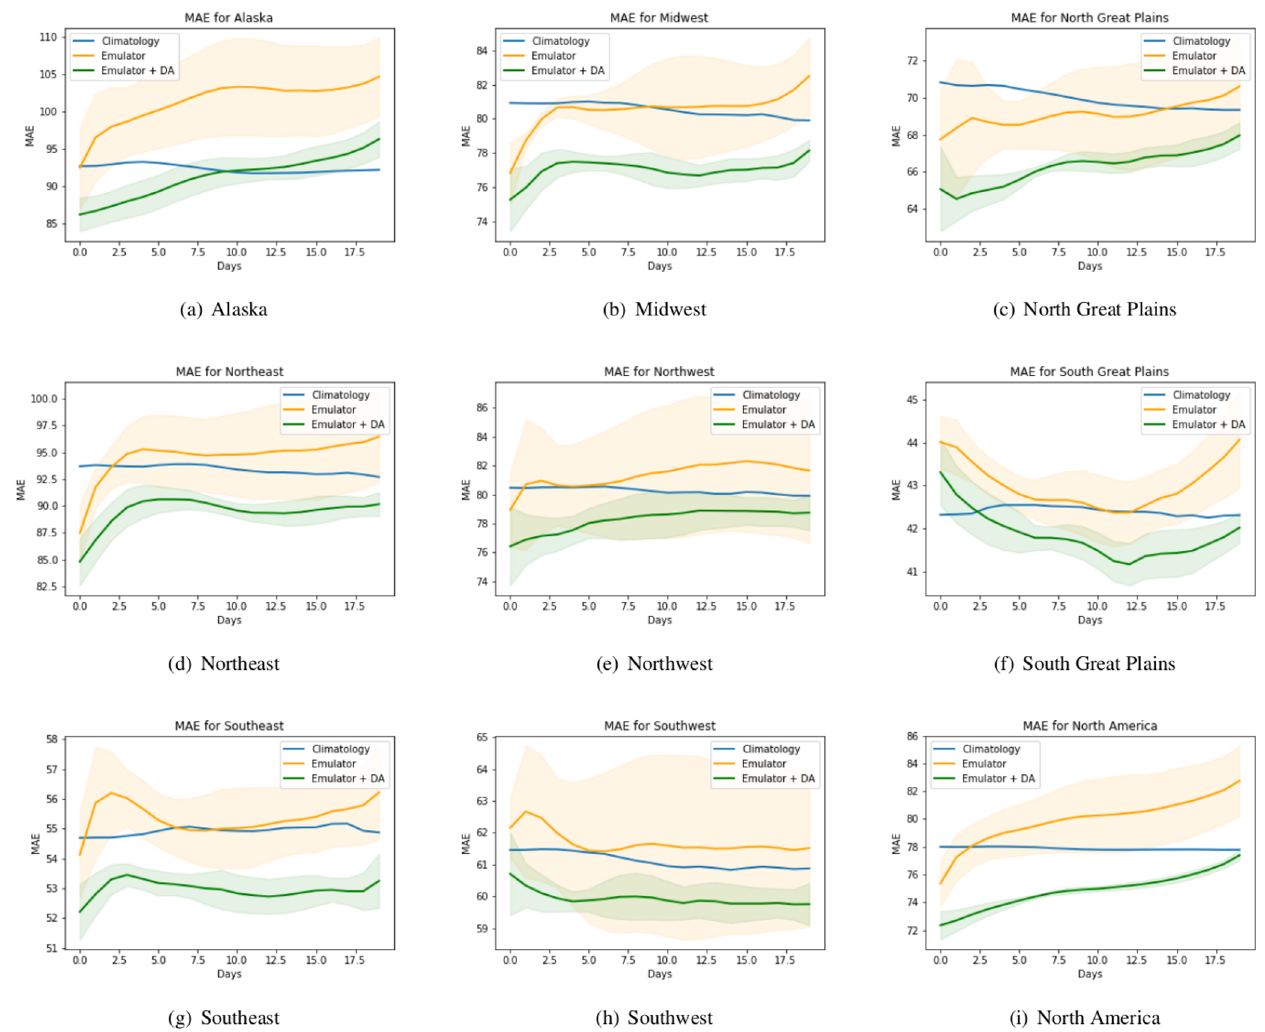
Figure 4. Geopotential height forecast MAEs for 20d, relative to the true test data, for seven National Climate Assessment subregions of continental North America (Reidmiller et al., 2018), from both a regular ML emulator and the same emulator corrected by variational DA. Confidence intervals, for five separately trained emulators, encapsulate the effects of perturbations to the random seed and the input window. DA-based correction gives both lower MAEs and narrower confidence